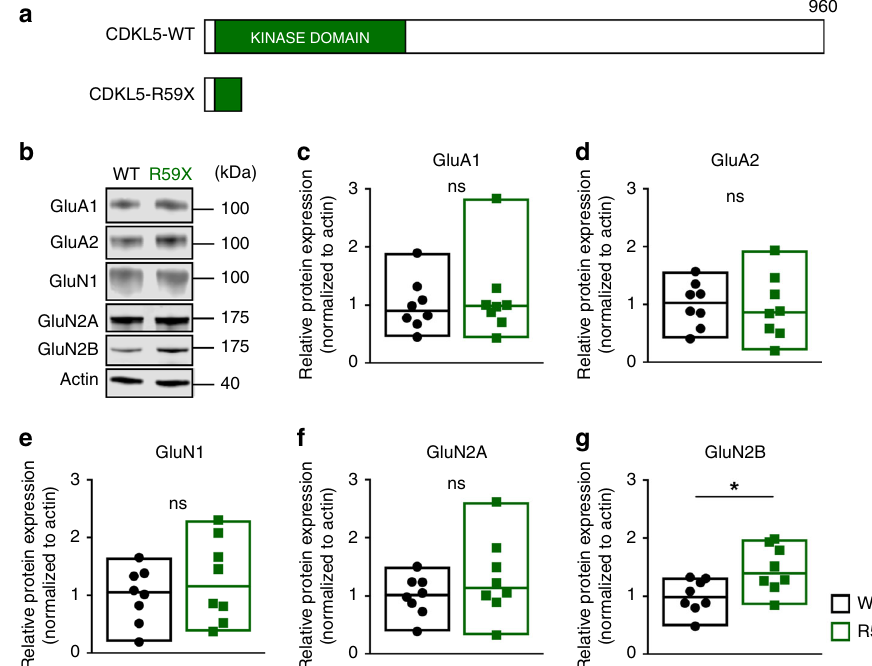
Fig. 6 R59X mice have an upregulation of NMDA receptors at the postsynaptic membrane. a Schematic of the R59X nonsense mutation at arginine 59, which results in early truncation of the catalytic domain of CDKL5. b Representative western blot results for several major ionotropic glutamate receptor subunits from postsynaptic density membrane fractions. Samples are from pairs of WT and R59X littermates. c – g R59X mice show a selective increase in level of GluN2B, a major subunit of the NMDA receptor (WT, n = 8 mice; R59X, n = 8 mice; unpaired t- test or Mann – Whitney test). Full-scan western blots of all samples are available in Supplemental Fig. 6. Source data are provided as a Source Data fi